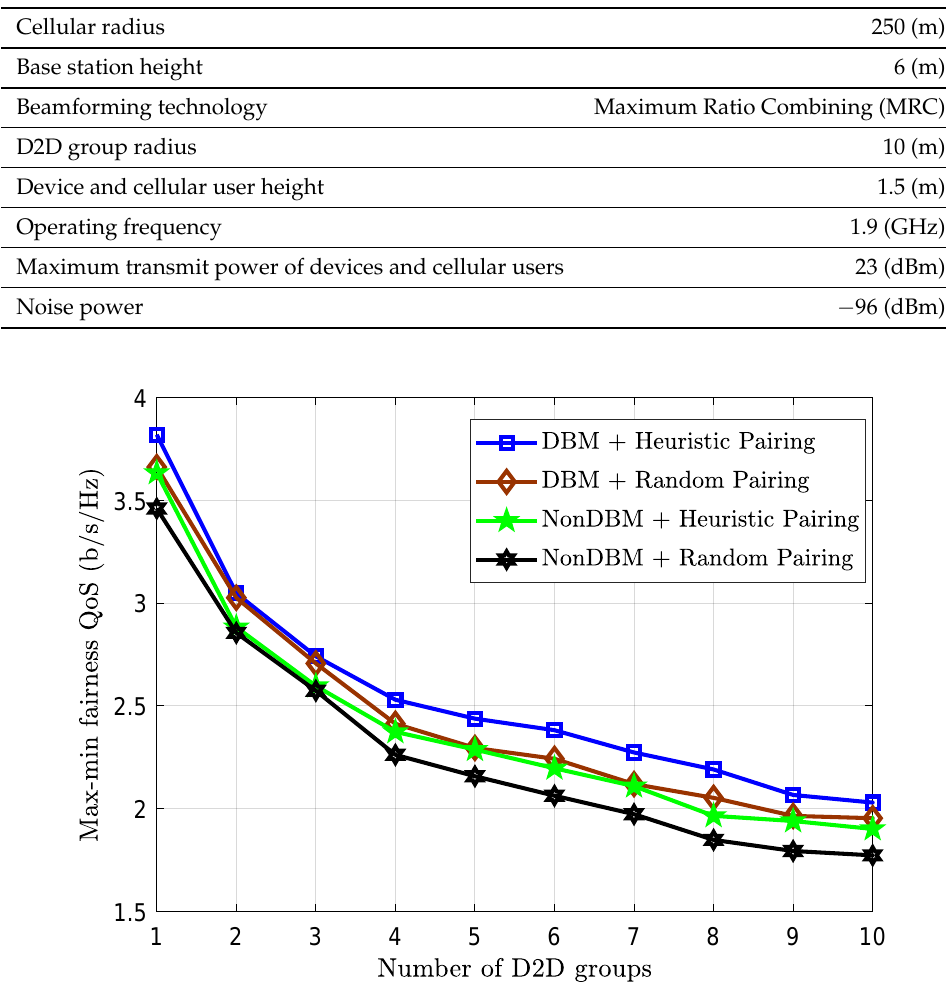
Figure 2. The max-min fairness QoS (bit/s/Hz) versus the number of D2D